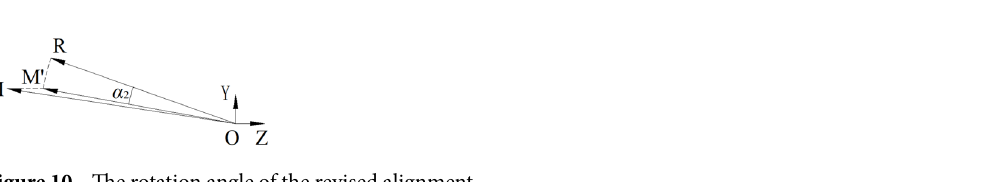
Figure 9. Revised alignment. From left to right: selection of the infection point of the plastic glasses leg and the top point of the ear with showing the face, the infection point of the plastic glasses leg and the top point of the ear with red and blue points and sublines through points along X axis, revised alignment result, revised alignment result with showing the face and the myopic glasses.